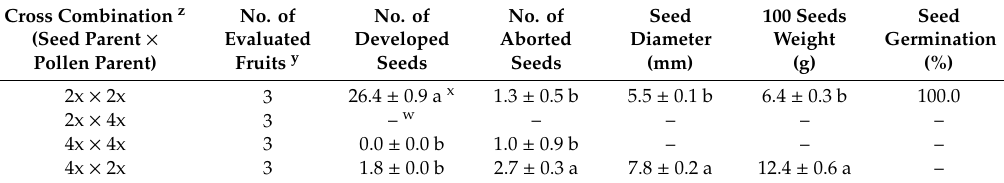
Table 7. Comparison of the seed traits in di ff erent cross combinations between the diploid and colchicine induced tetraploid pointed gourd